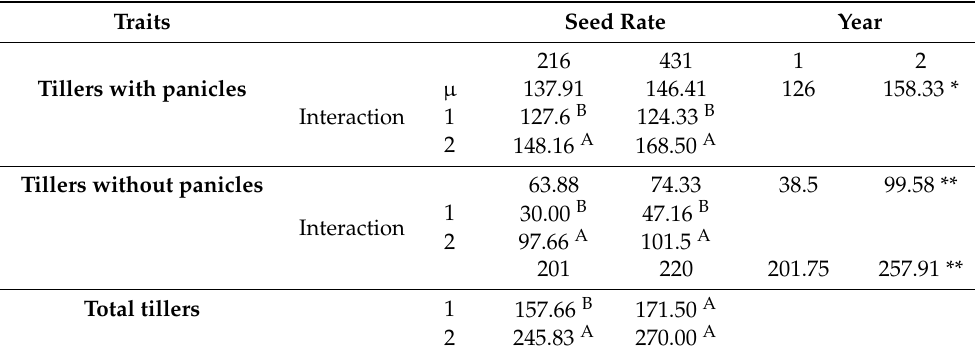
Table 4. Effect of seed rates and environment years 2018 (1) and 2020 (2) on the number of tillers that produced panicles, number of tillers without panicles, and total tillers. Traits Seed Rate Year 216 431 Tillers with panicles µ